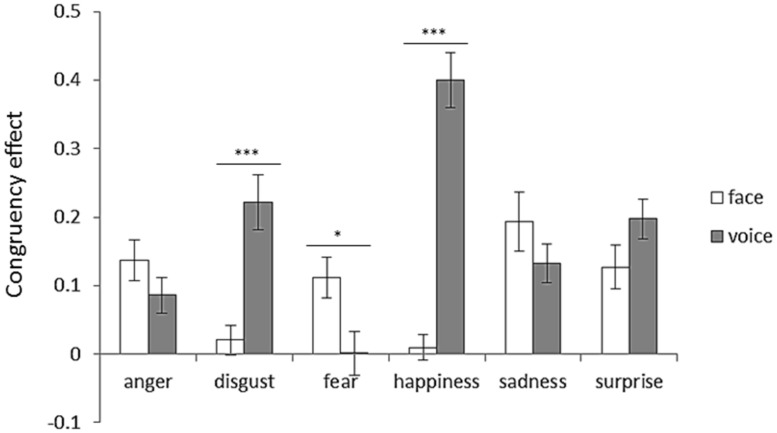
Congruency effect for each emotion category with respect to attended modality. Error bars represent SE. Asterisks indicate significant differences between attended modalities (*p < 0.05, ***p < 0.001). “V > A” in Table 3 was the case that the bar length of the face was shorter than that of the voice, and “A > V” in Table 3 was the case that the bar length of the voice was shorter than that of the face.